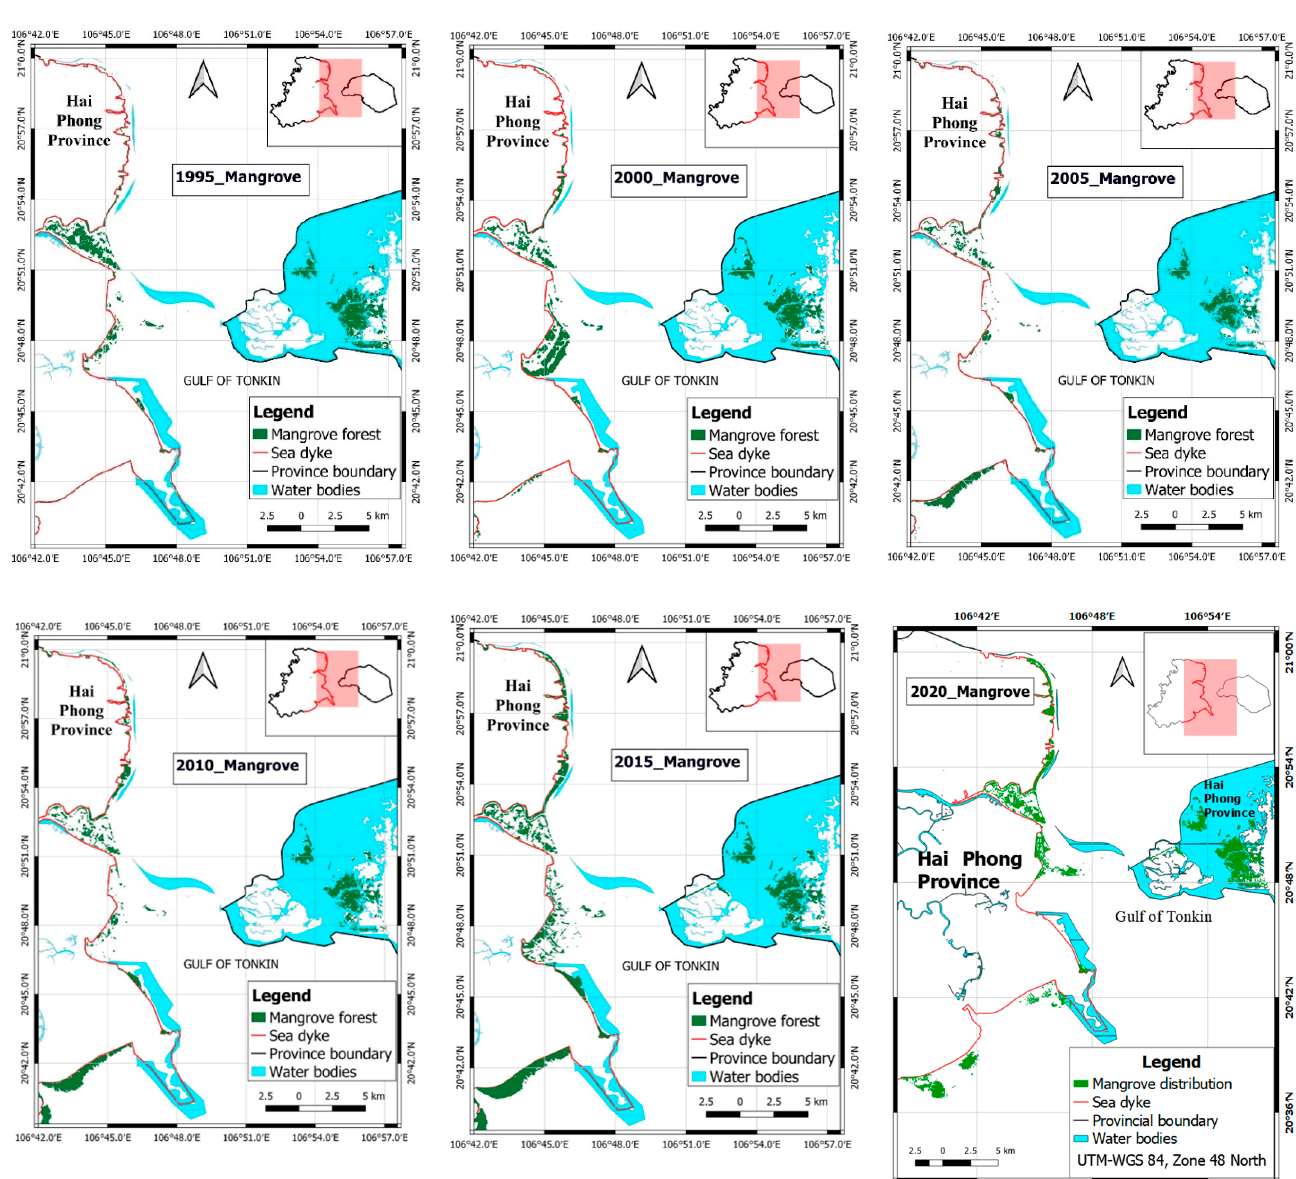
Figure A1. Mangrove distribution maps in Hai Phong between 1995 and 2020.